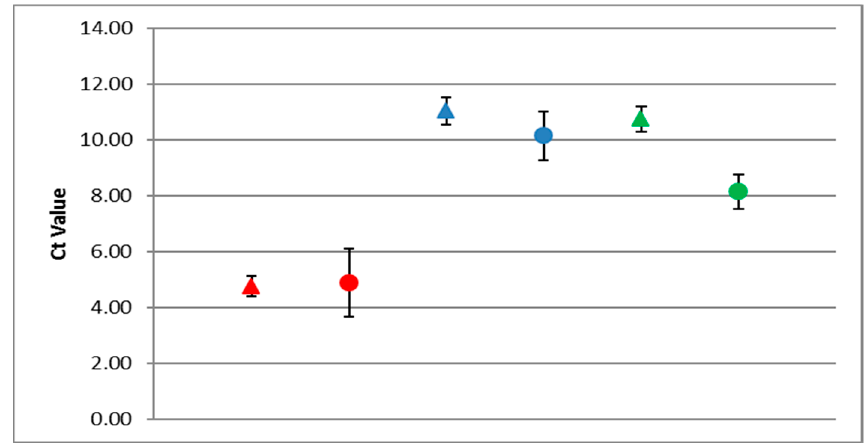
Figure 4. ABC assay. Red = DWV type A, blue = DWV type B, and green = DWV type C. Triangles represent DWV target only, and circles represent DWV samples containing multiple variants. Error bars represent the standard deviation from the mean C t .